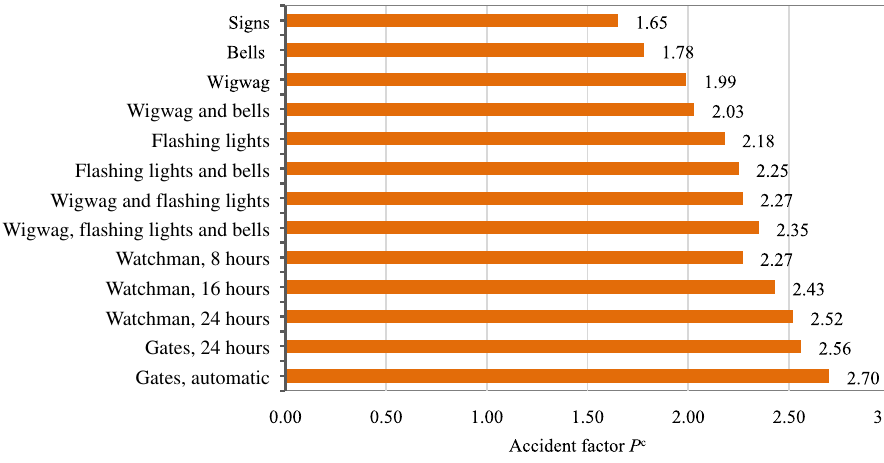
Fig. 6 Relationship between warning device type and accident factor P